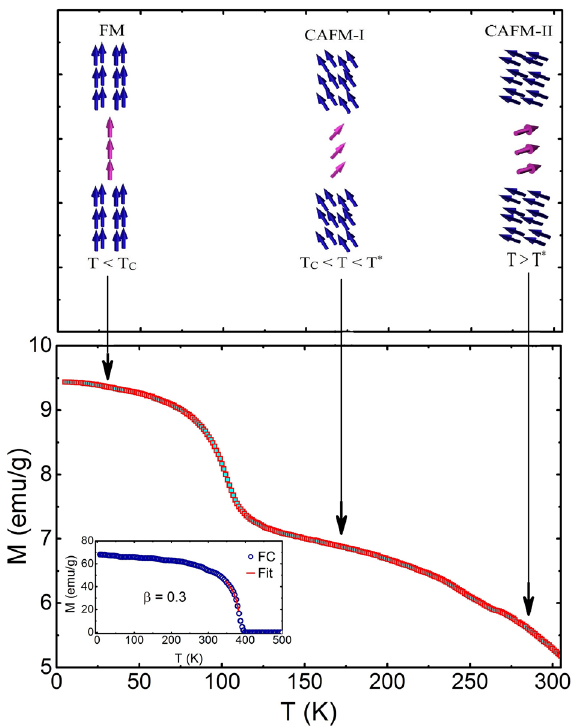
Figure 10. Spin structure in the different temperature range of TL-LSMO-0.3. Below T C , i.e., T < T C the spins have FM alignment. First type of canting of spins occur in the range T C < T < T ∗ and above T ∗ second type of canting is represented. The inset shows the FC curve for infinite-layer La 0.7 Sr 0.3 MnO 3 57 . The solid line (red color) represents the fit to the Eq. (8) and yield the value of exponent β = 0.3. (Figures have been drawn using OriginPro 2015